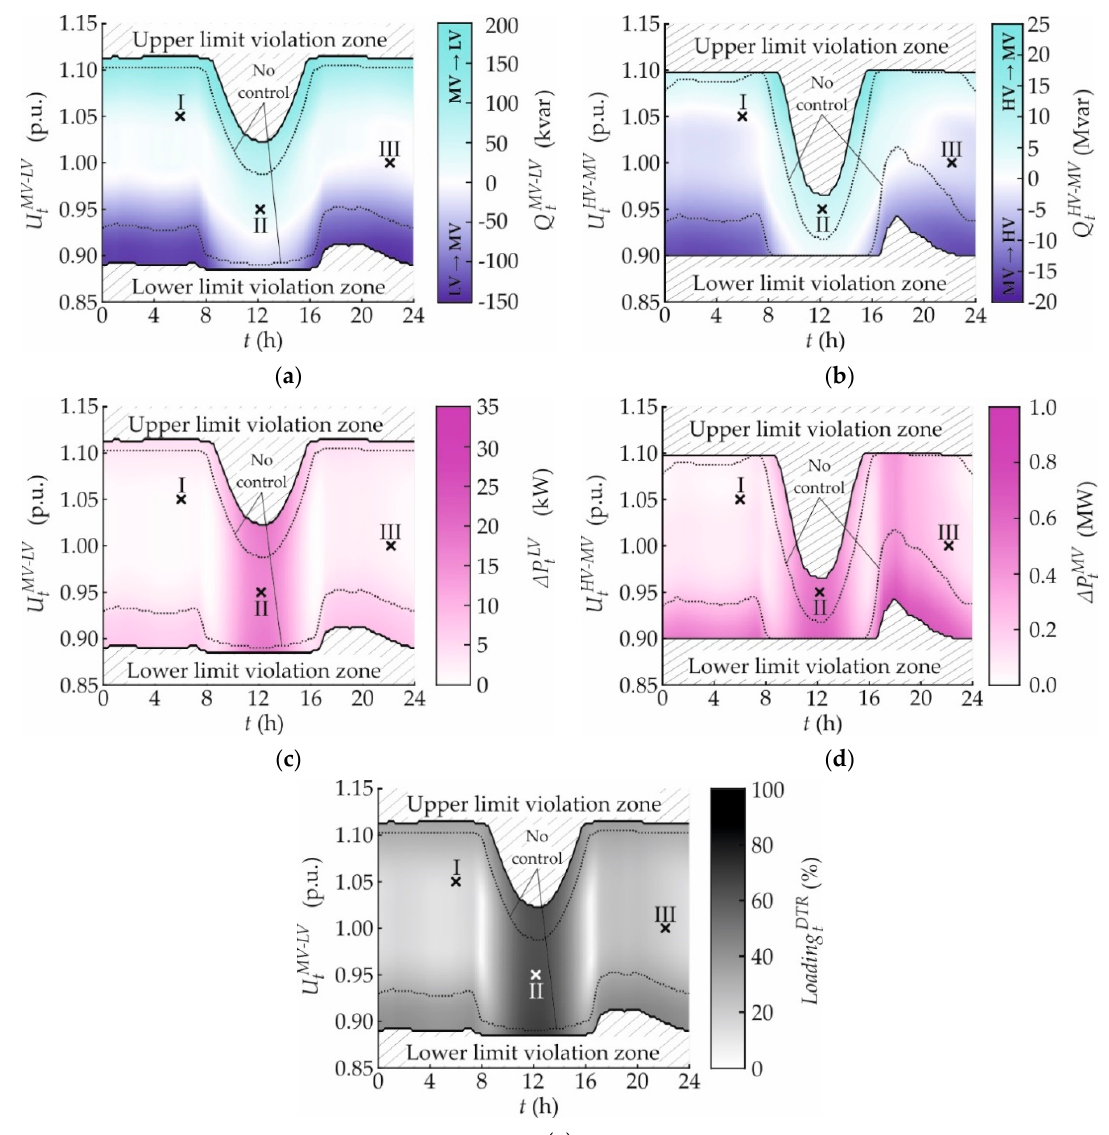
Figure 17. Daily behavior of the test link chain for various boundary voltages and the Q ( U ) local control: ( a ) reactive power exchange over the MV − LV boundary (rural LV_Link-Grid); ( b ) reactive power exchange over the HV − MV boundary; ( c ) active power loss within the rural LV_Link-Grid; ( d ) active power loss within the MV_Link-Grid; ( e ) DTR loading (rural LV_Link-Grid).